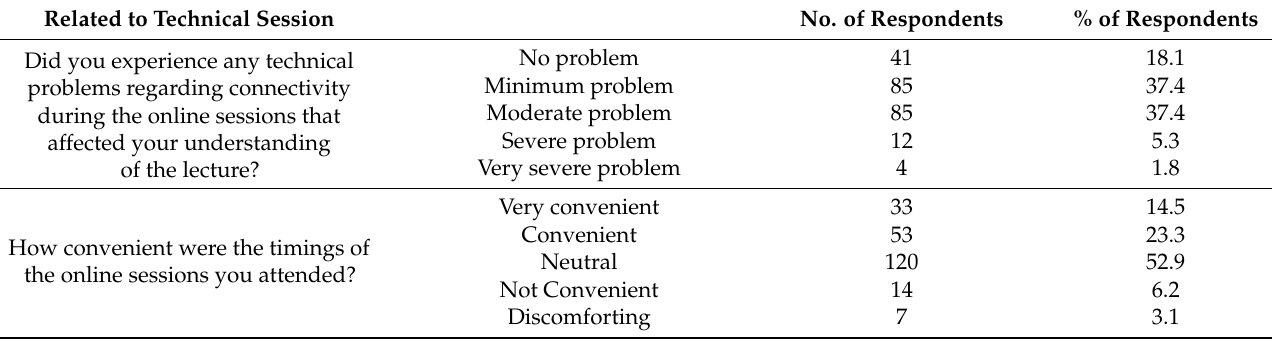
Table 3. Distribution of responses related to technical